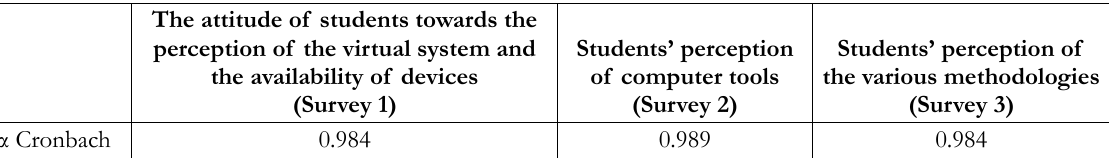
Table 5. α Cronbach from the surveys used